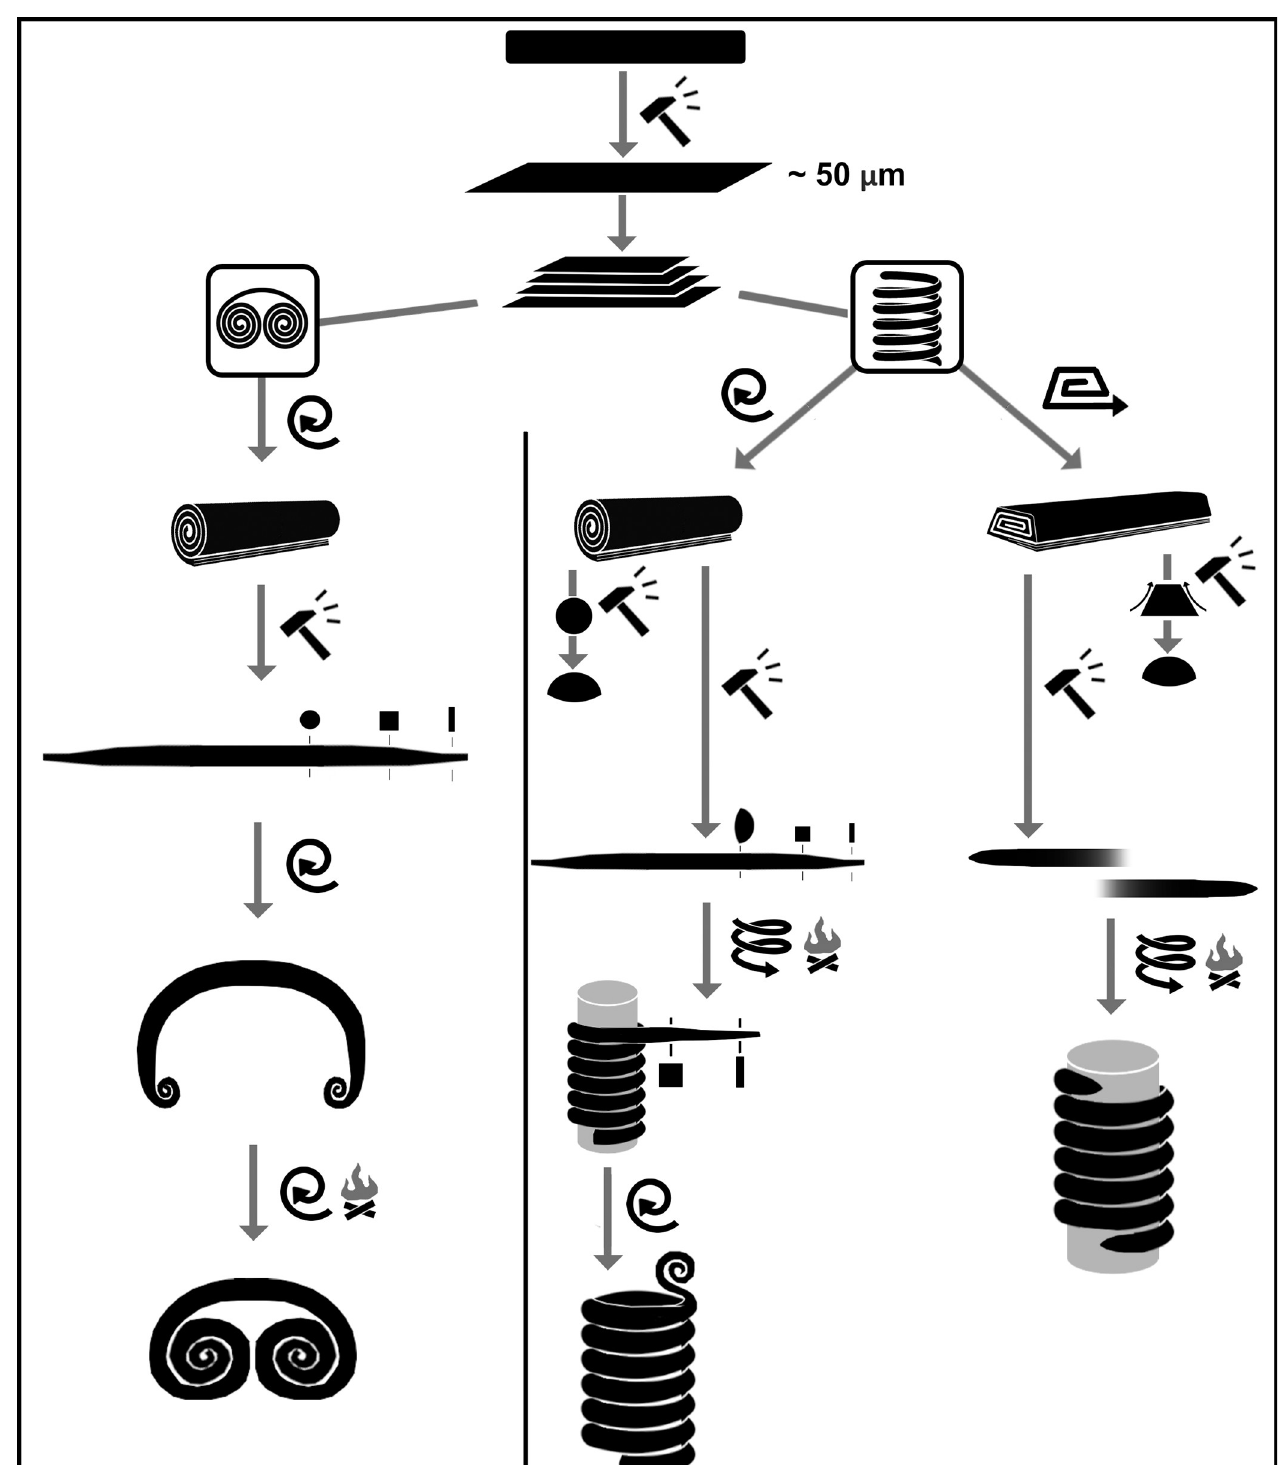
Fig 23. The reconstruction of chaîne opératoire of spectacle spiral pendants and spiral bracelets. Drawn by Katalin Seb ő k.